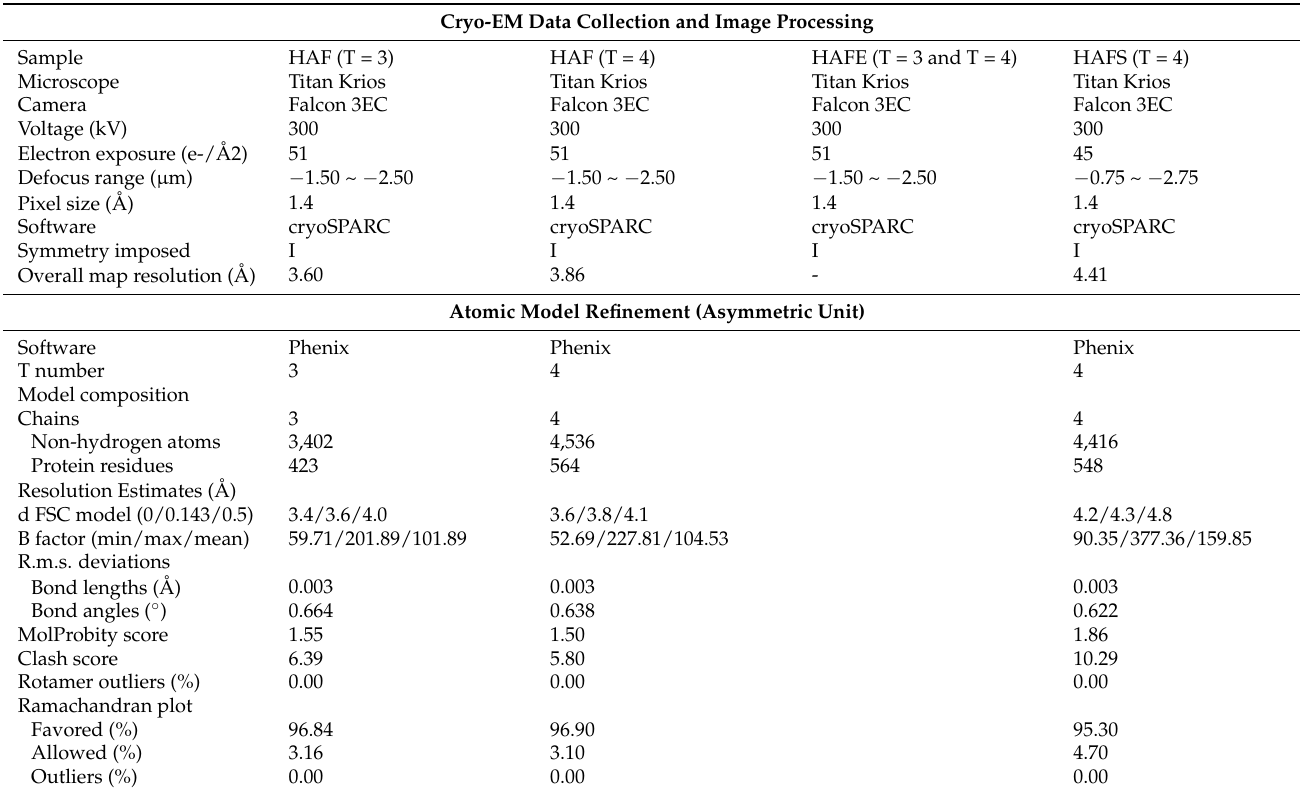
Table 1. Summary of data collection, structure determination, and model building of HAF, HAFE, and